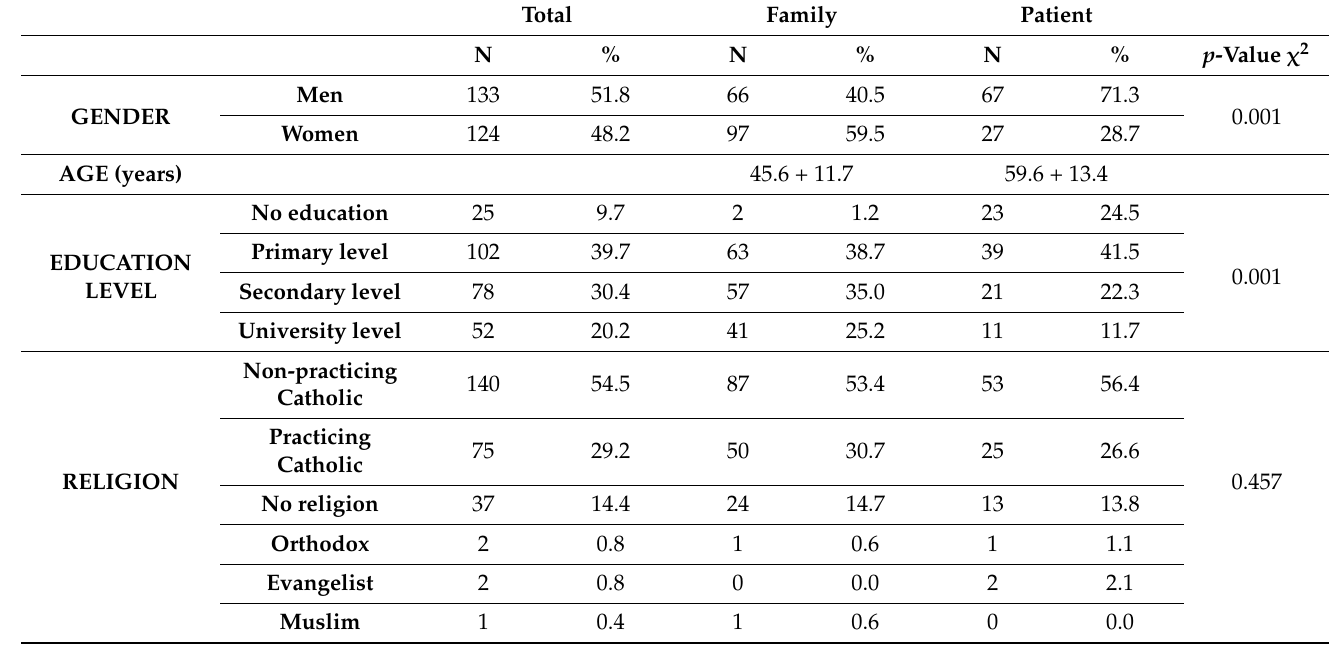
Table 1. Patients/Family